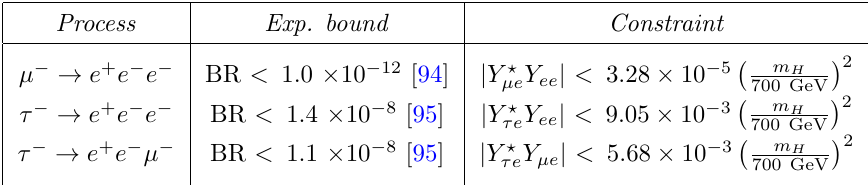
Table 7 . Constraints on Yukawa couplings as a function of heavy neutral scalar mass from ‘ (cid:11) ‘ (cid:12) ‘ (cid:13) ‘ (cid:14) decay (with at least two of the (cid:12)nal state leptons of electron (cid:13)avor to be relevant for NSI). decays are obtained in the limit when the masses of the decay products are neglected.